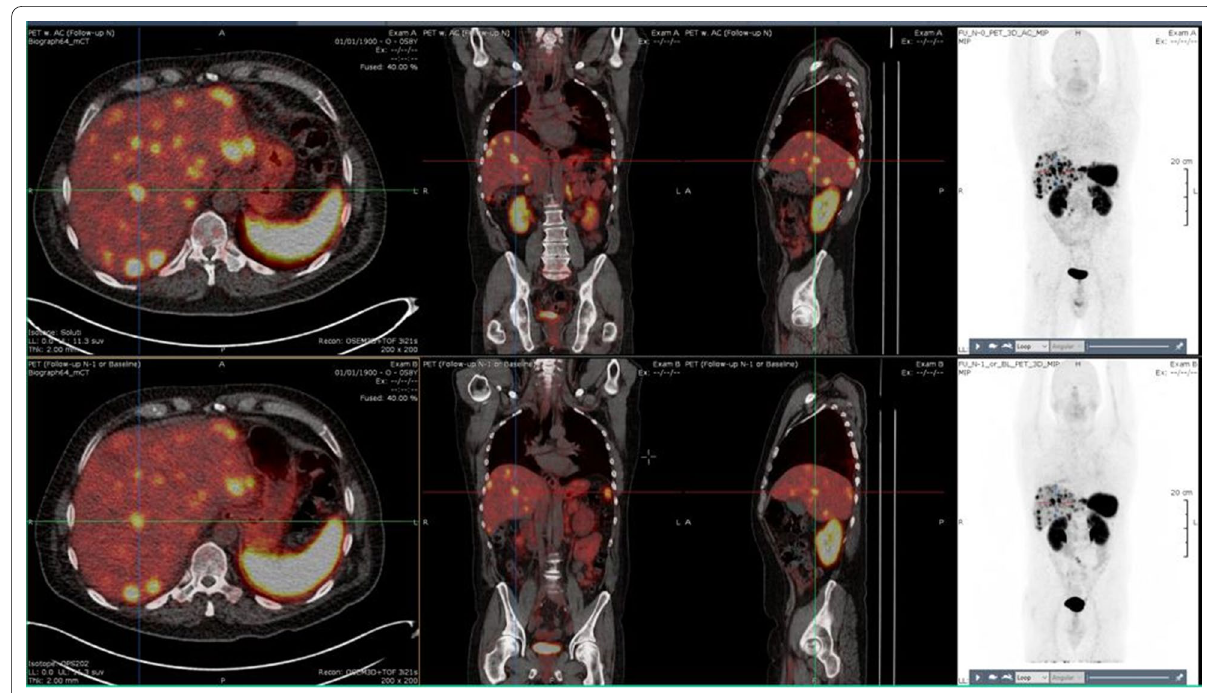
Fig. 3 Two 68 Ga-satoreotide trizoxetan PET/CT fused images with maximum intensity projection of the same patient acquired at two different timepoints separated by 2–3 weeks. In the top panel, the patient had received 68 Ga-satoreotide trizoxetan at 16 µg/165 MBq. In the lower panel, the